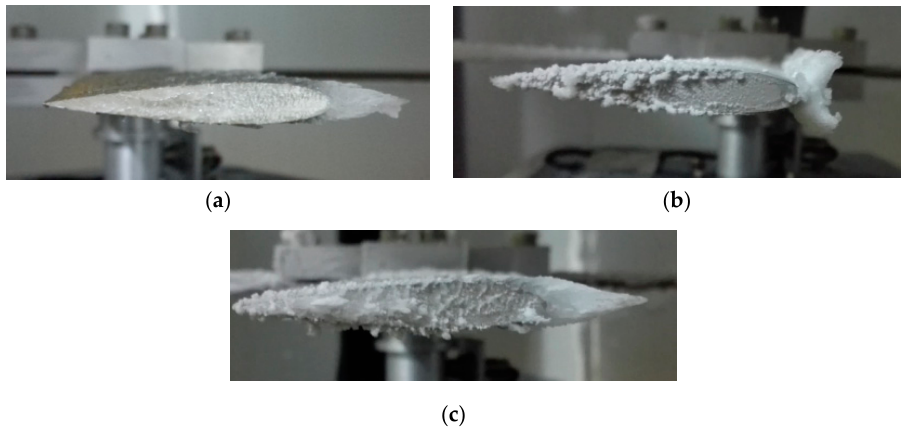
Figure 7. Ice shapes under different icing temperatures: ( a ) case 1: icing temperature was − 10 °C, mixed ice; ( b ) case 2: icing temperature was − 5 °C, glaze ice; ( c ) case 3: icing temperature was − 15 °C, rime ice.